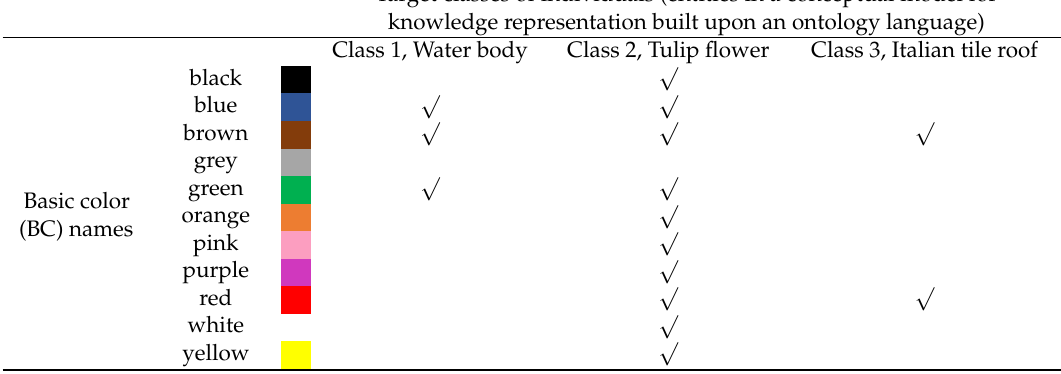
Table 6. Example of a binary relationship R: A ⇒ B ⊆ A × B from set A = DictionaryOfColorNames, with cardinality |A| = a = ColorVocabularyCardinality = 11, and the set B = LegendOfObjectClassNames, with cardinality |B| = b = ObjectClassLegendCardinality = 3, where A × B is the 2-fold Cartesian product between sets A and B. The Cartesian product of two sets A × B is a set whose elements are ordered pairs. The size of A × B is rows × columns = a × b. The dictionary LegendOfObjectClassNames is a superset of the typical taxonomy of land cover (LC) classes adopted by the RS community. “Correct” entry-pairs √ (marked with ) must be: (i) selected by domain experts based on a hybrid combination of deductive prior beliefs with inductive evidence from data and (ii) community-agreed upon, to be used by members of the community